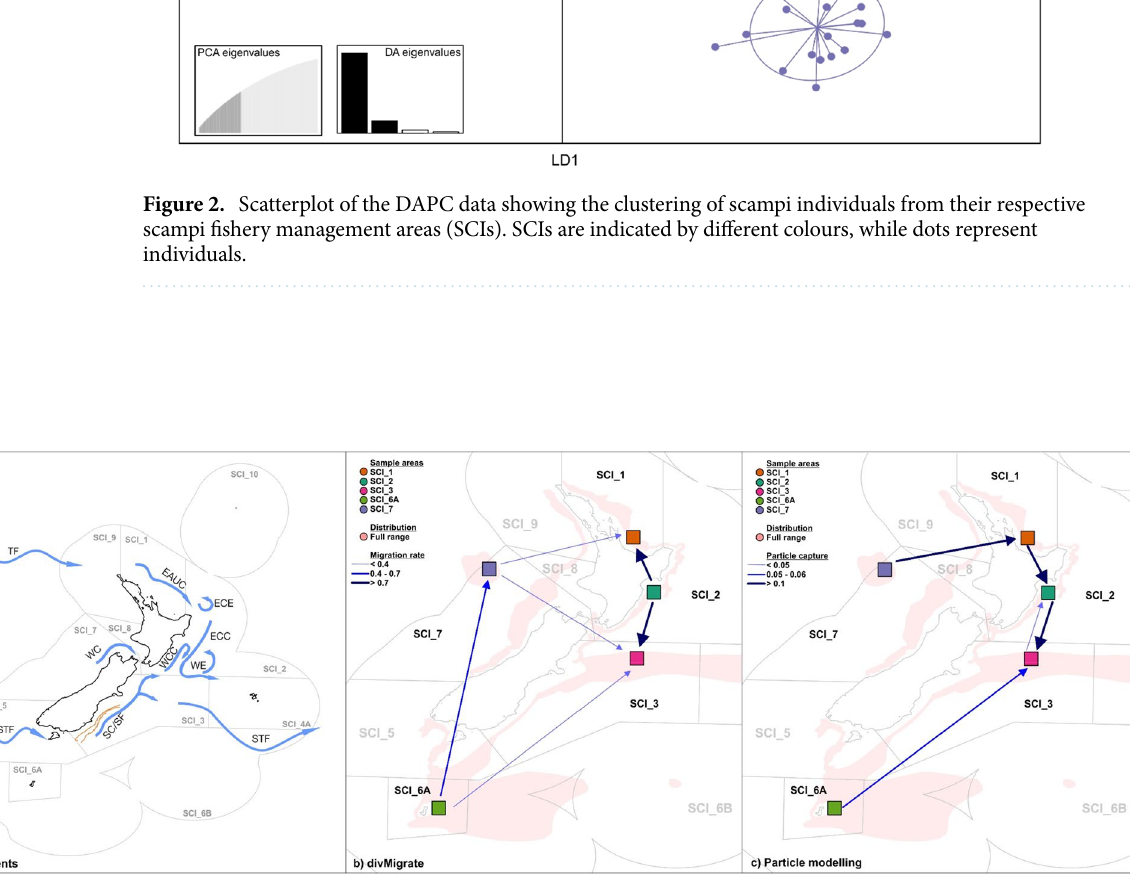
Figure 3. ( a ) Currents surrounding New Zealand that are likely to have influenced scampi migration rates between scampi stocks. ( b ) Migration rates estimated from genetic data using divMigrate and compared with ( c ) particle migration between adjacent scampi stocks from hydrodynamic modelling. ( a ) The direction of two of New Zealand’s major ocean fronts are indicated on the map, the Tasman Front (TF) and the Sub-Tropical Front (STF). Other major currents include the East Auckland Current (EAUC), the Southland Current/Front (SC/SF), the Wairarapa Coastal Current (WCC), the East Cape Current (ECC) and Westland Current (WC). Semi-permanent eddies embedded in the flows are the Wairarapa Eddy (WE) and East Cape Eddy (ECE). The Otago shelf edge is outlined in orange. The ocean current information was adapted from Chiswell and Booth 34 . ( b ) divMigrate relative migration rates between adjacent populations indicating higher rates of migration among SCI_1, SCI_2 and SCI_3, and between SCI_6A and SCI_7 (Table S8). The arrow direction points to which population is more likely to act as a sink among the adjacent SCIs. ( c ) The arrow direction indicates the resulting direction of particle movements from hydrodynamic particle modelling (Table S9). Indicated on the maps ( b ) and ( c ) are the sampling areas within each SCI (coloured square; Table S1), and the approximate full scampi range and fishery management areas 28 .The figure’s main elements, i.e., New Zealand and sample areas, were generated with ggplot2 v3.3.3 114 , mapdata v2.3.0 115 and mapproj v1.2.7 116 . Other aesthetic elements were added using Corel Draw Essentials X5